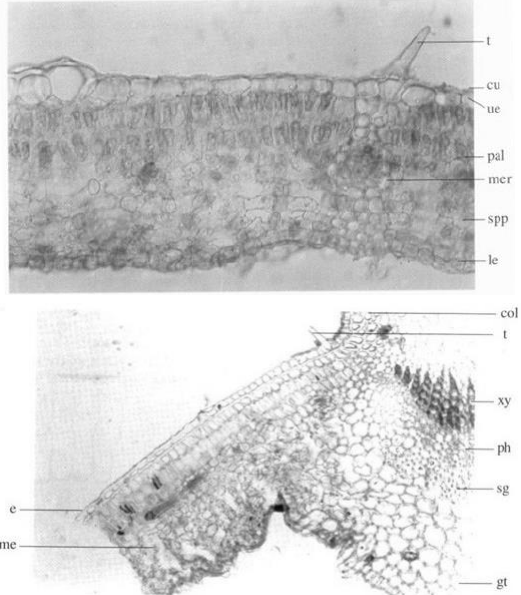
Figure 1: Microscopy of N. arbor-tristis leaf. Figure 1a represents microscopy of the leaf TS through midrib where col=collenchyma; e=epidermis; gt=ground tissue; me=mesophyll; ph=pholem; sg=starch grains; t=trichome; xy=xylem. Figure 1b represents microscopy of the leaf TS through lamina where cu=cuticle; le=lower epidermis; mer=meristele; pal=palisade; spp=spongy parenchyma; t=trichome; ue=upper epidermis. The transverse section of leaf passing through the mid-rib convexly projects on the lower side, and slightly grooved with a shallow central elevation on the upper